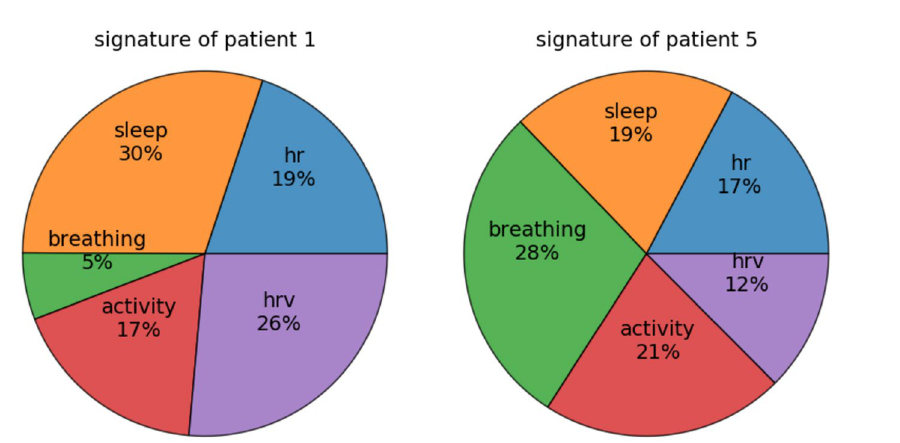
Figure 7. Physiological features repartition in feature groups for 2 patients. Example biosignatures of depressive symptoms determined by our algorithm for 2 patients (see Table 2 for their optimal features number ν). The circular histogram represents the importance of each group of features in the patient’s signature; a group is considered more important if the size of its wedge is larger. The symptoms of patient 1 are more represented in the sleep variables, whereas those of patient 5 are visible in the breathing rate